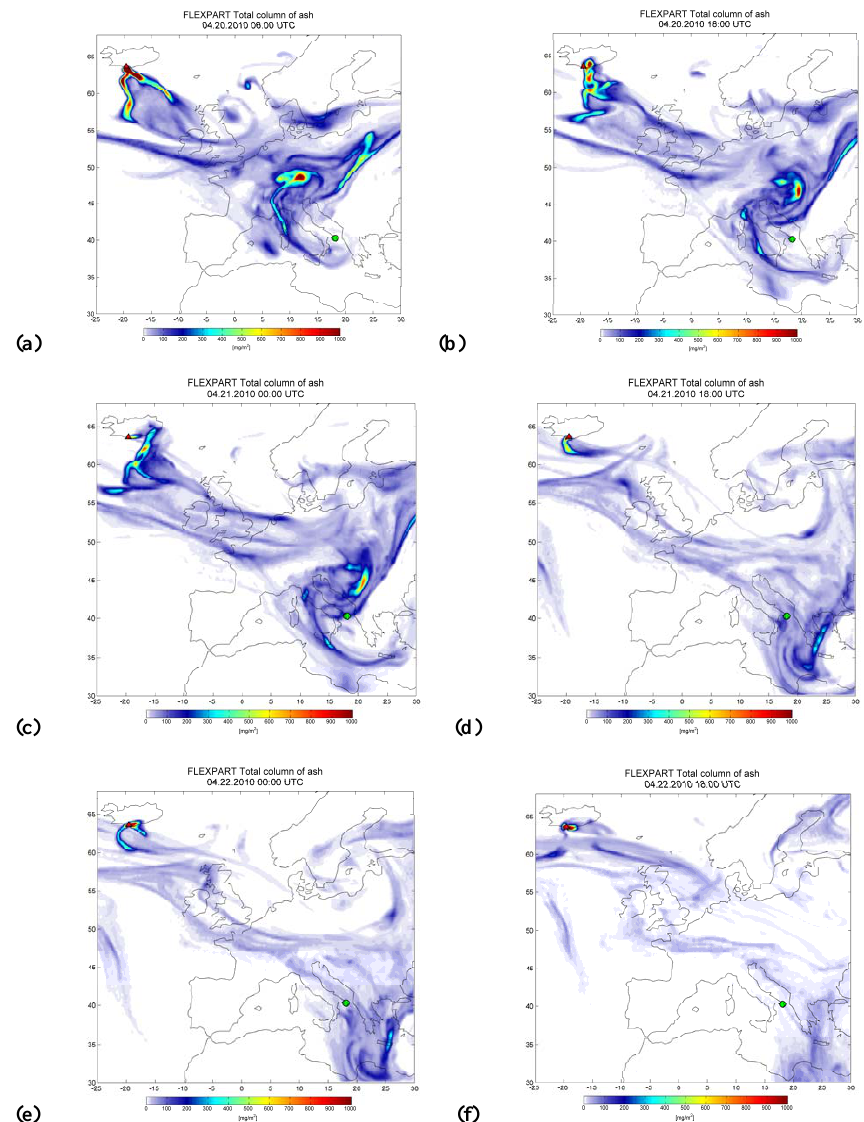
Fig. 2. FLEXPART simulations of the Eyjafjallaj ¨ okull volcanic ash (total atmospheric columns in mgm − 2 , integrated over all 25 particle size classes) on 20 April at (a) 06:00UTC, (b) 18:00UTC, (c) 24:00UTC, on 21 April at (d) 18:00UTC, (e) 24:00UTC, and on 22 April at (f) 18:00UTC. The green dot marks the monitoring site.